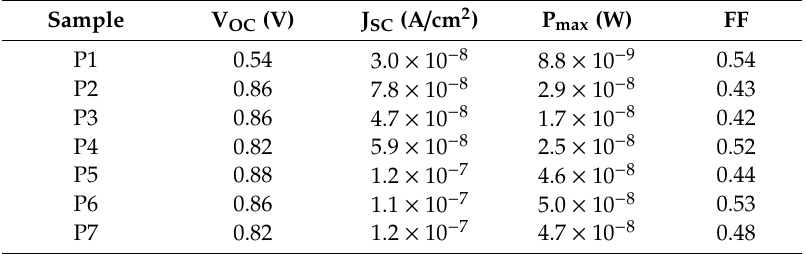
Table 2. Electrical parameters of the structures developed on the MAPLE-deposited